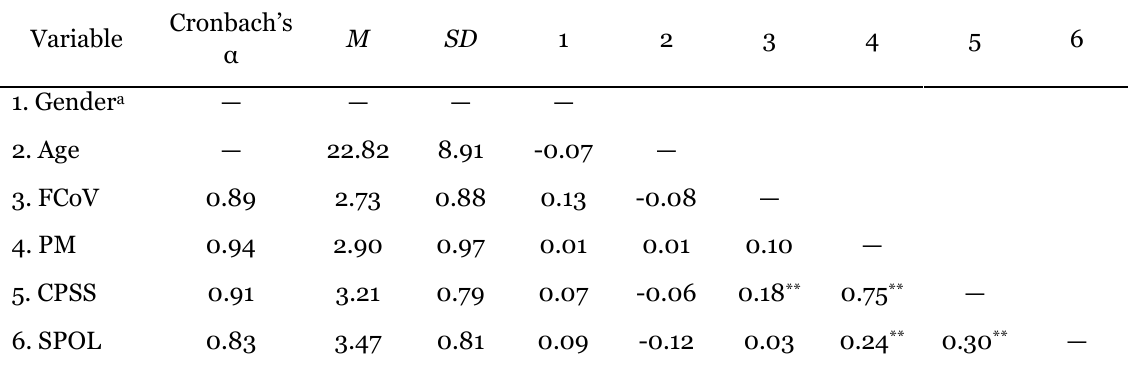
Cronbach’s Alpha, Means, Standard Deviations, and Correlations for the Study Variables